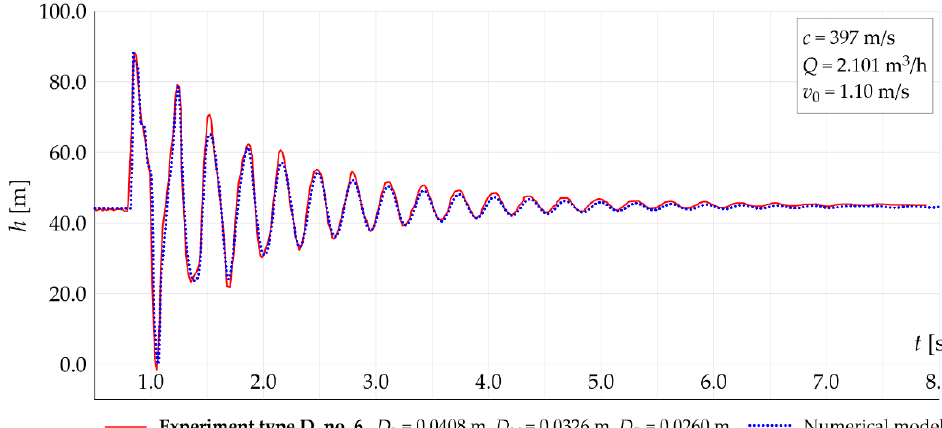
Figure 8. Calculated and observed pressure oscillations during experiment no. 5.